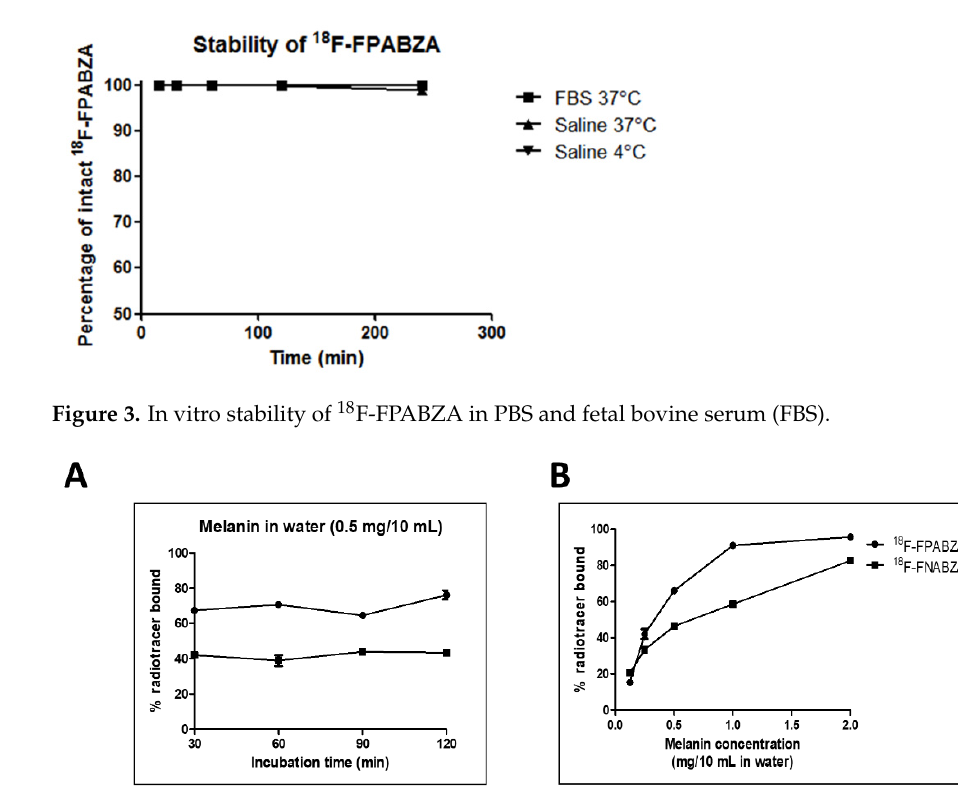
Figure 4. In vitro binding affinity of 18 F-FPABZA and 18 F-FNABZA to melanin. ( A ) The bound ratios of 18 F-FPABZA and 18 F-FNABZA with melanin suspension (0.5 mg/10 mL) at 37 °C for various incubation durations. ( B ) Binding with various concentrations of melanin at 37 °C for 1 h.